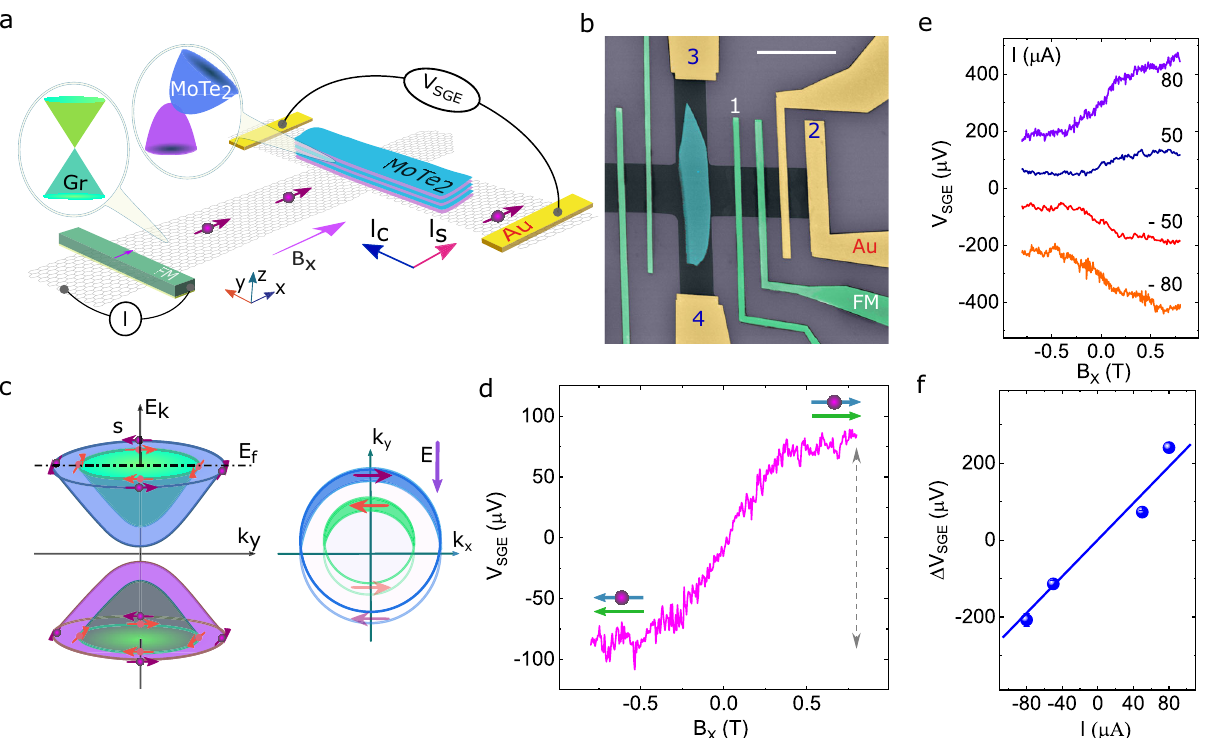
Fig. 1 Proximity-induced spin-galvanic effect in graphene-MoTe 2 van der Waals heterostructure at room temperature. a , b The spintronic device schematics with the measurement scheme and colored scanning electron microscopic (SEM) image consisting of graphene (gray)/MoTe 2 (blue) heterostructure on Si/SiO 2 substrate, ferromagnetic (FM) and non-magnetic (Ti/Au) contacts on graphene. The scale bar in the SEM image is 6 µ m. c A schematic band diagram of modi fi ed graphene in a heterostructure with MoTe 2 , showing Rashba spin-split conduction and valence bands in accordance with the energy in momentum space ( E k ), where Fermi energy ( E f ) is in the conduction band. Application of an electric fi eld with such spin texture is expected to create a spin accumulation due to the Rashba-Edelstein effect (REE), and inversely, a spin accumulation can be converted to a charge voltage via inverse Rashba-Edelstein effect (IREE). d Measured spin-galvanic effect as a non-local voltage ( V SGE ) signal due to IREE by injecting a spin current ( I s ) from a FM into the graphene-MoTe 2 heterostructure region. A change in V SGE is measured by sweeping a magnetic fi eld along the x -axis ( B x ) with an application of I = 80 µ A, the gate voltage V g = − 10V in Dev 1 at room temperature. The green and blue arrows denote the FM magnetization and direction of the diffused spin into the graphene-MoTe 2 heterostructure, respectively. e , f Measured bias dependence of V SGE signal and its magnitude Δ V SGE as a function of bias current in Dev 1. A linear background is subtracted from the data and shifted in the y -axis for clarity. The line is the linear fi t to the data in f . The error bars are calculated from the noise level of the manifested signals and not clearly visible because error bars are smaller than the data fi nally detected as a voltage signal ( V range and saturates at magnetic fi elds above B ≈ ± 0.4 T (see SGE ) across the Hall-bar structure with non-magnetic Ti/Au contacts on graphene. Due to Supplementary Fig. S5, where a x-Hanle measurement shows the the IREE in the Gr-MoTe 2 heterostructure region with a possi- saturation fi eld of the FM contact). A giant spin-galvanic signal bility of spin-split bands (Fig. 1c), the diffused spin-polarized has been obtained at room temperature with an amplitude up to Δ R = Δ V I ~ 4.96 Ω (with I = − 80 µA at V = 40 V) and carriers create a non-equilibrium spin density across the hetero- SGE SGE / g lower bound of the ef fi ciency ( α RE ) of IREE is estimated to be structure with a net momentum along the ± y -axis depending on 7.6% by using the Eq. (1) 17,34 . the spin direction (±s). This is detected as a voltage signal, V SGE ( I c ) ∝ z x n s ( I s ); here, I c , z and n s are the induced charge current, w Δ R MoTe out-of-plane direction non-equilibrium spin density accumulated ¼ α SGE 2 RE ð 1 Þ L þ wMoTe via spin current I s , respectively. The direction of the injected spin 2 ρ G 2 λ P λ e (cid:2) L λ G (cid:2) e (cid:2) G G (in ±x-direction) and hence the V SGE is controlled by sweeping a magnetic fi eld in the x-direction (± B x ), which induces spin pre- cession together with rotation and saturates the magnetization of (2.3 µm), λ G (2.65 µm), ρ G (1.6 k Ω ), and Here, Δ R SGE , P , w MoTe 2 L (3.37 µm) are the signal amplitude, the spin polarization of Co/ the injector FM (Fig. 1d). The spin precession due to the applied x- fi eld (± B x ) will be in the y – z plane, and the projection of spin TiO 2 contact (considering 10%, see Supplementary Fig. S6), the polarization along the x -axis will be the same during the spin width of the MoTe 2 fl ake, spin diffusion length, channel resistivity, and channel length, respectively. Here, we consider density ( n s ) depends on the spin direction towards the x -axis (±x) the spin diffusion length of the pristine graphene region since no spin precession signal is observed in the Gr-MoTe 2 hetero- projection along the x -axis during the spin precession, together structure region. However, we would like to mention that the estimated α RE is the lower limit as the spin diffusion length in Gr- resulting IREE signal increases with B x until the saturation of FM MoTe 2 heterostructure is smaller due to the enhanced SOI. This magnitude of the observed R SGE and α RE is found to be larger sion. Accordingly, the measured V SGE increases in the low fi eld than the previous results on 2D materials heterostructures 16,17 .